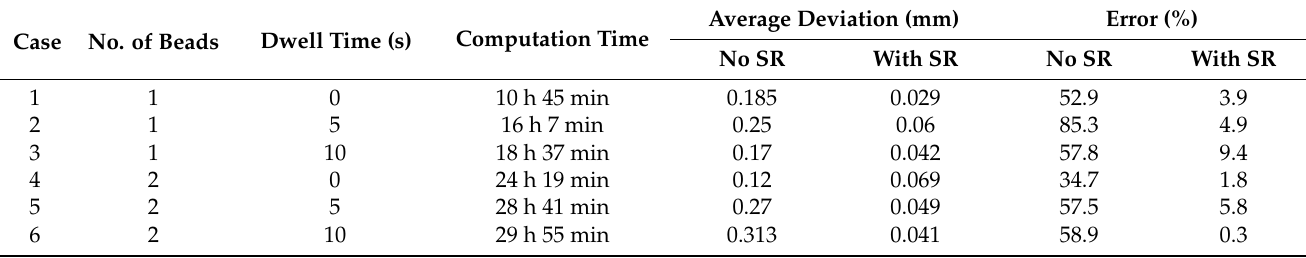
Table 4. Experiment cases examined for mechanical model validation via LDS.